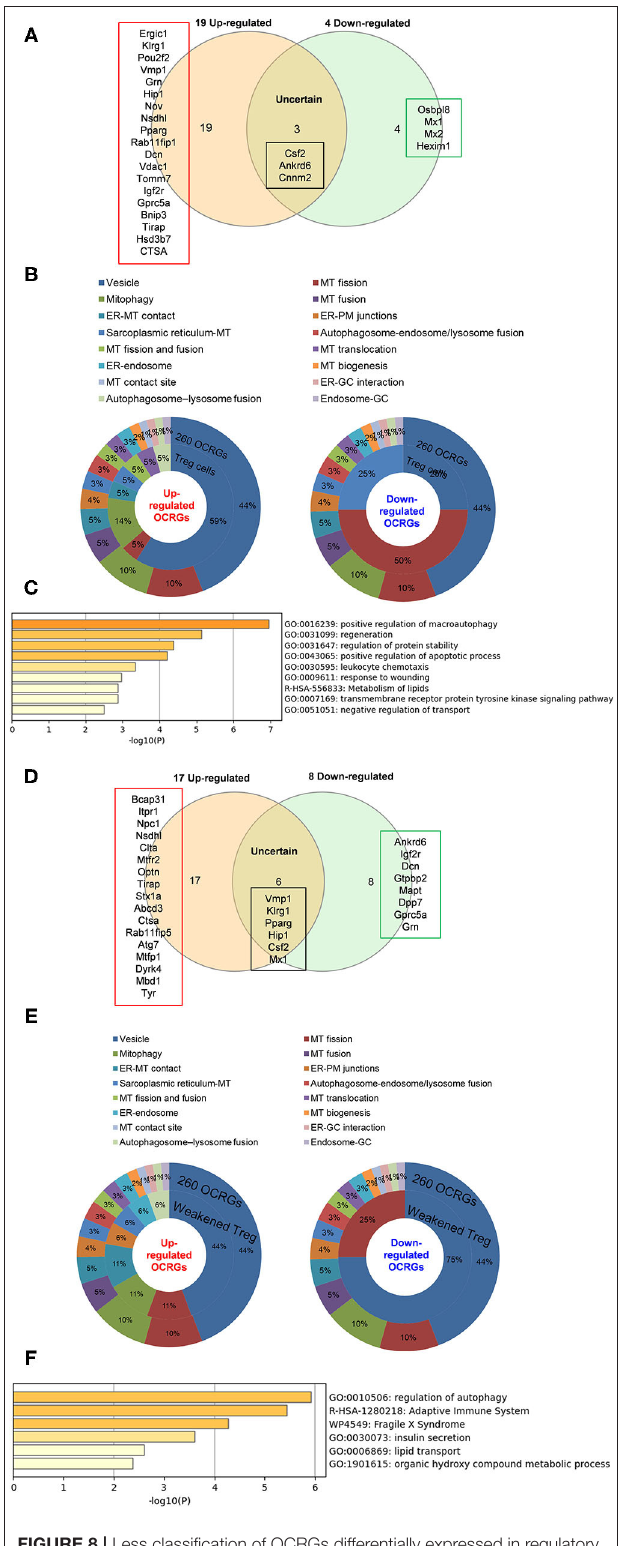
FIGURE 8 | Less classification of OCRGs differentially expressed in regulatory T cells and weakened Treg cells. (A) When the overlapped three genes in all upregulated OCRGs and in all downregulated OCRGs were removed, 19